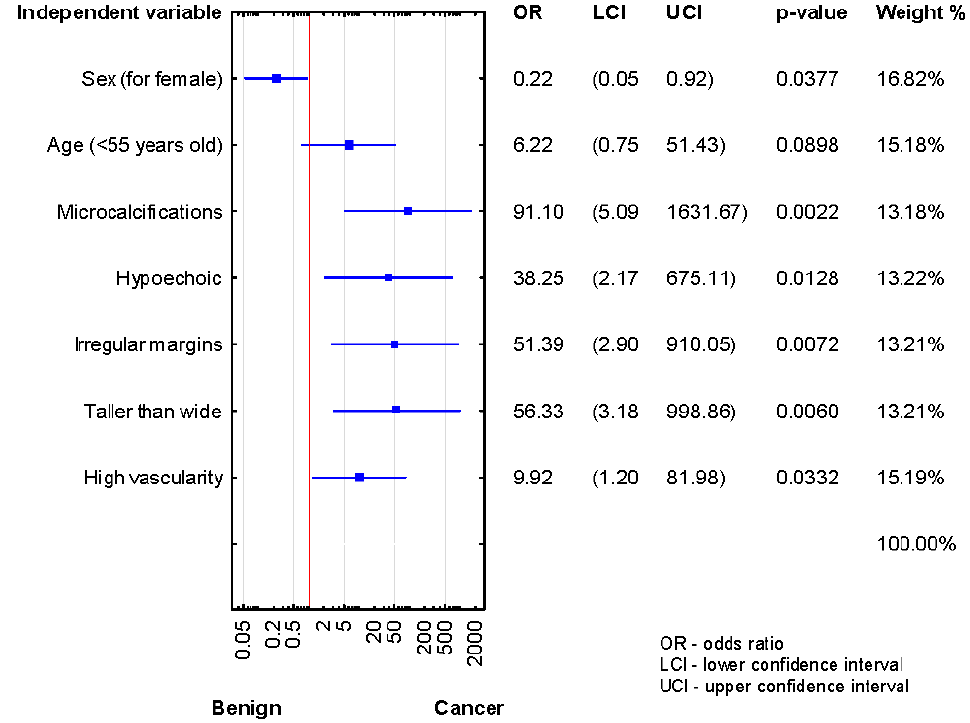
Figure 2. Forrest plot showing the odds ratios for cancer risk in the patients after the first diagnosis of AUS/FLUS ( n = 121). After the second biopsy, the thyroidectomy group showed higher malignancy rates in hypoechogenicity and taller-than-wide shape ( p < 0.05) (Figure 3).